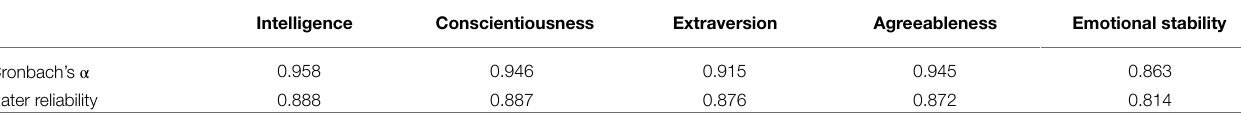
TABLE 1 | The rater reliability and the Cronbach’s alphas of the scale.